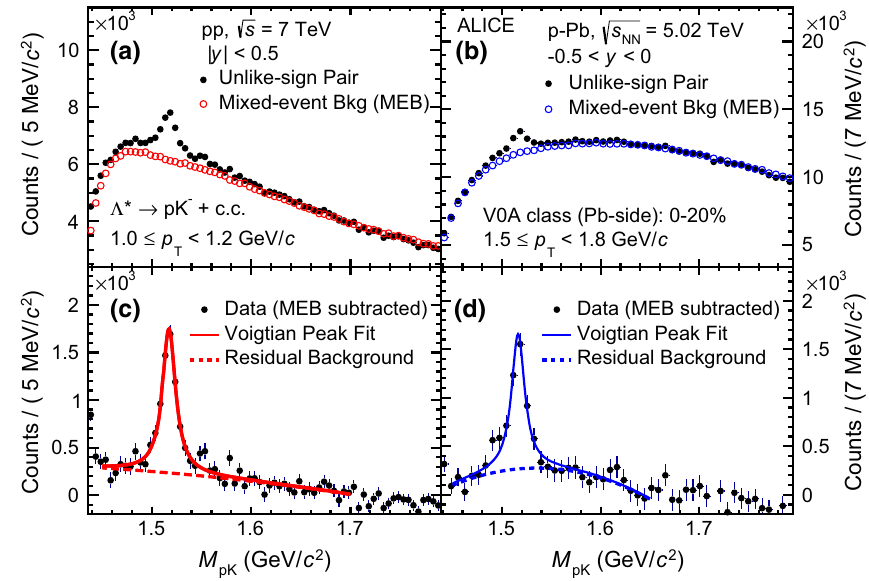
Fig. 1 Invariant-mass distributions of pK pairs for MB pp collisions √ s = 7 TeV (left panels) and for p–Pb collisions in the 0–20% mul- at √ s NN = 5 . 02 TeV (right panels) for the momen- tiplicity interval at tum interval 1 . 0 ≤ p T < 1 . 2 GeV / c and 1 . 5 ≤ p T < 1 . 8 GeV / c , respectively. Panels a and b show the unlike-sign pK invariant-mass distribution from the same event and normalized combinatorial back-